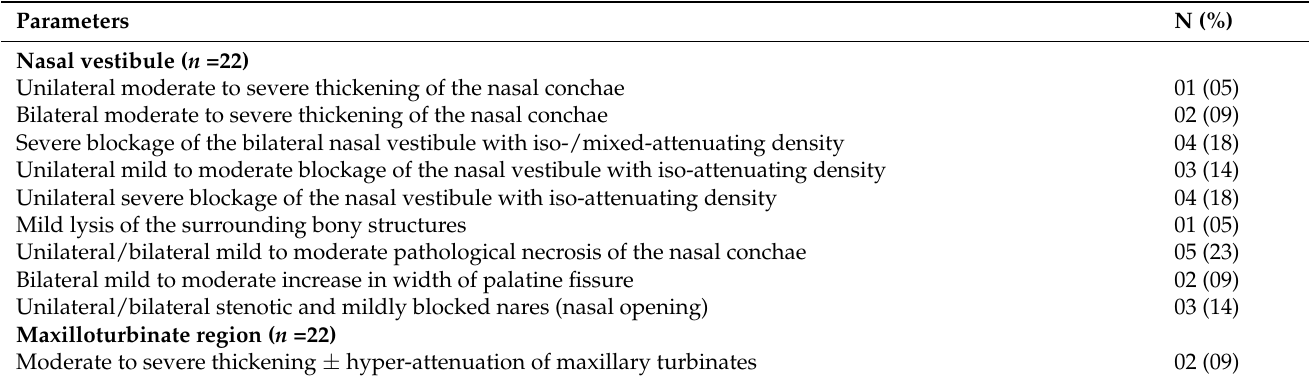
Table 9. Summary of the radiological findings in a total of 27 cats investigated for acute/chronic infectious respiratory disease